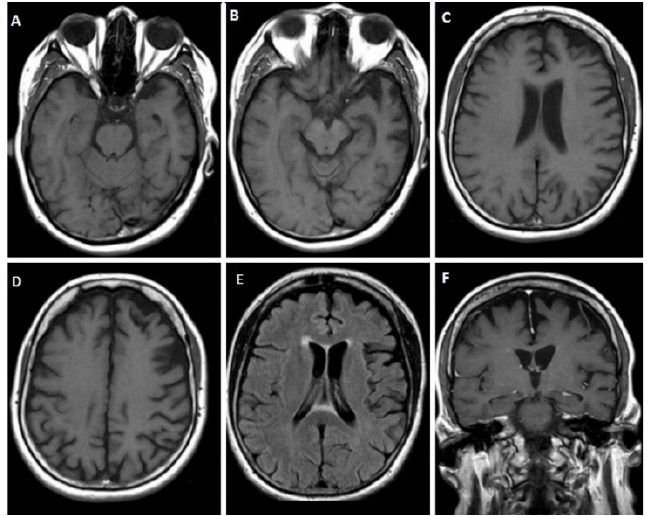
Figure 1. Brain MRI of case 1. T1 sequence ( A – D ) and fluid attenuated inversion recovery (FLAIR) ( E ) showing cortical atrophy in the frontal and temporal lobes, with left hemisphere being more affected, as well as coronal T1 section ( F ) showing relative preservation of the hippocampus.